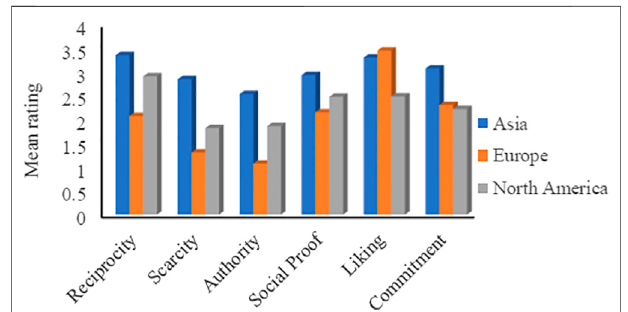
FIGURE4| Meanratingbasedonthecontinent(Asia:27%,Europe:6%, N. America: 67%).